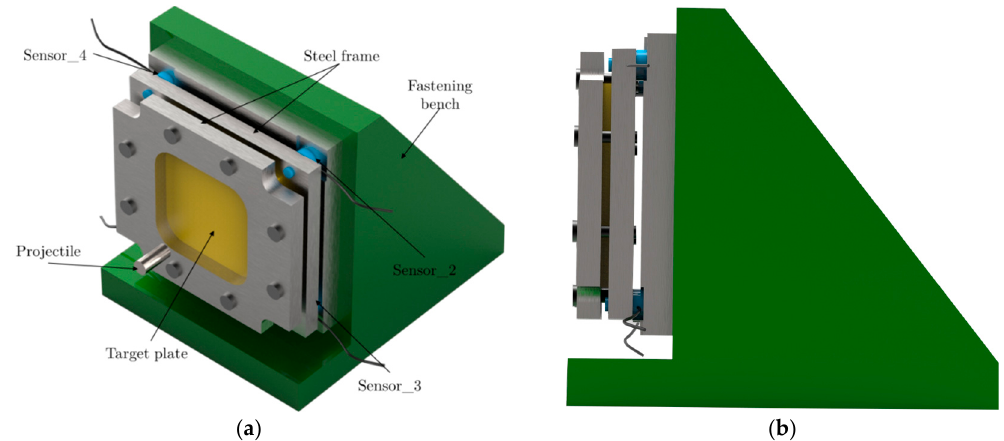
Figure 3. Target elements locations. ( a ) Perspective view; ( b ) Lateral view.